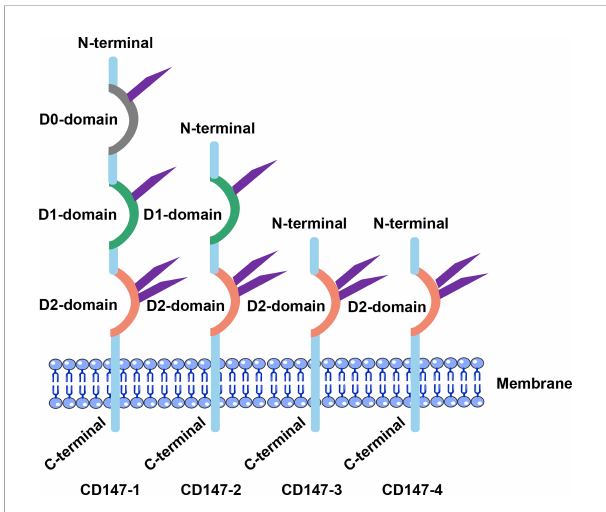
FIGURE 1 Structural characteristics of CD147. CD147 ’ s extracellular segments differed signi fi cantly. D0: retina-speci fi c structural domain; D1: Ig C2 structural domain; D2: Ig I structural